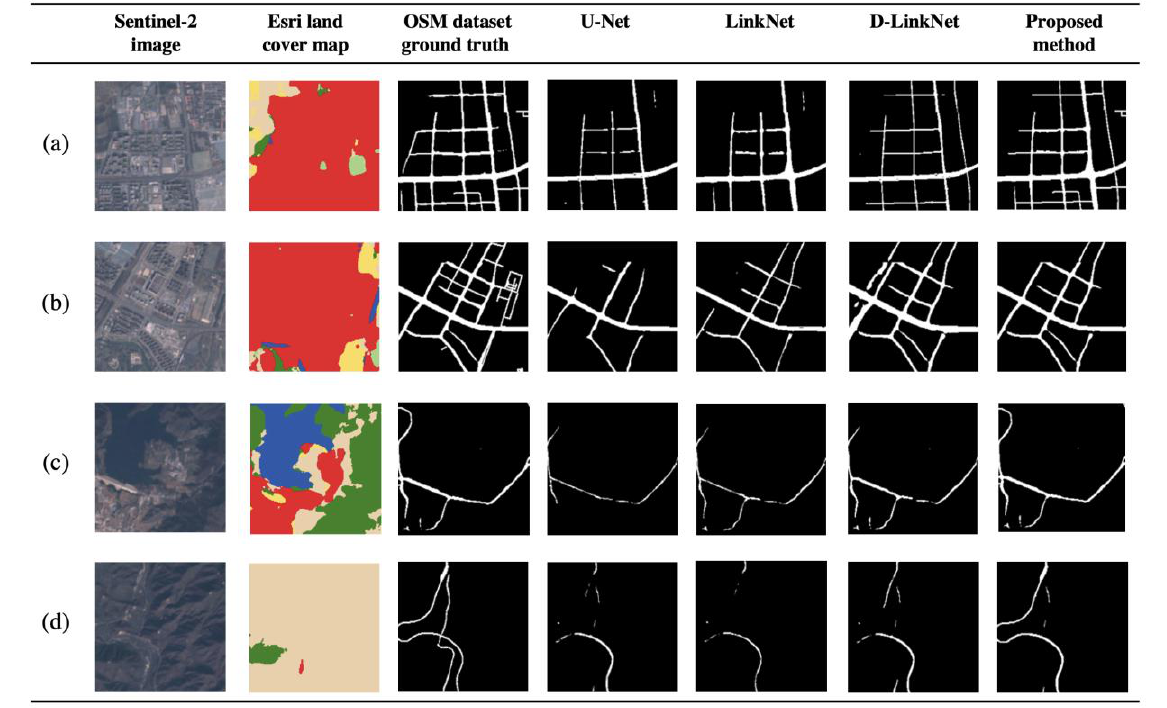
Figure 7. An example of the Road extraction results derived from different road extraction methods. ( a , b ) are two cases where Built Area is dominant; ( c ) is a case with very complicated land cover background, while ( d ) is a case where Scrub/Shrub is dominant.